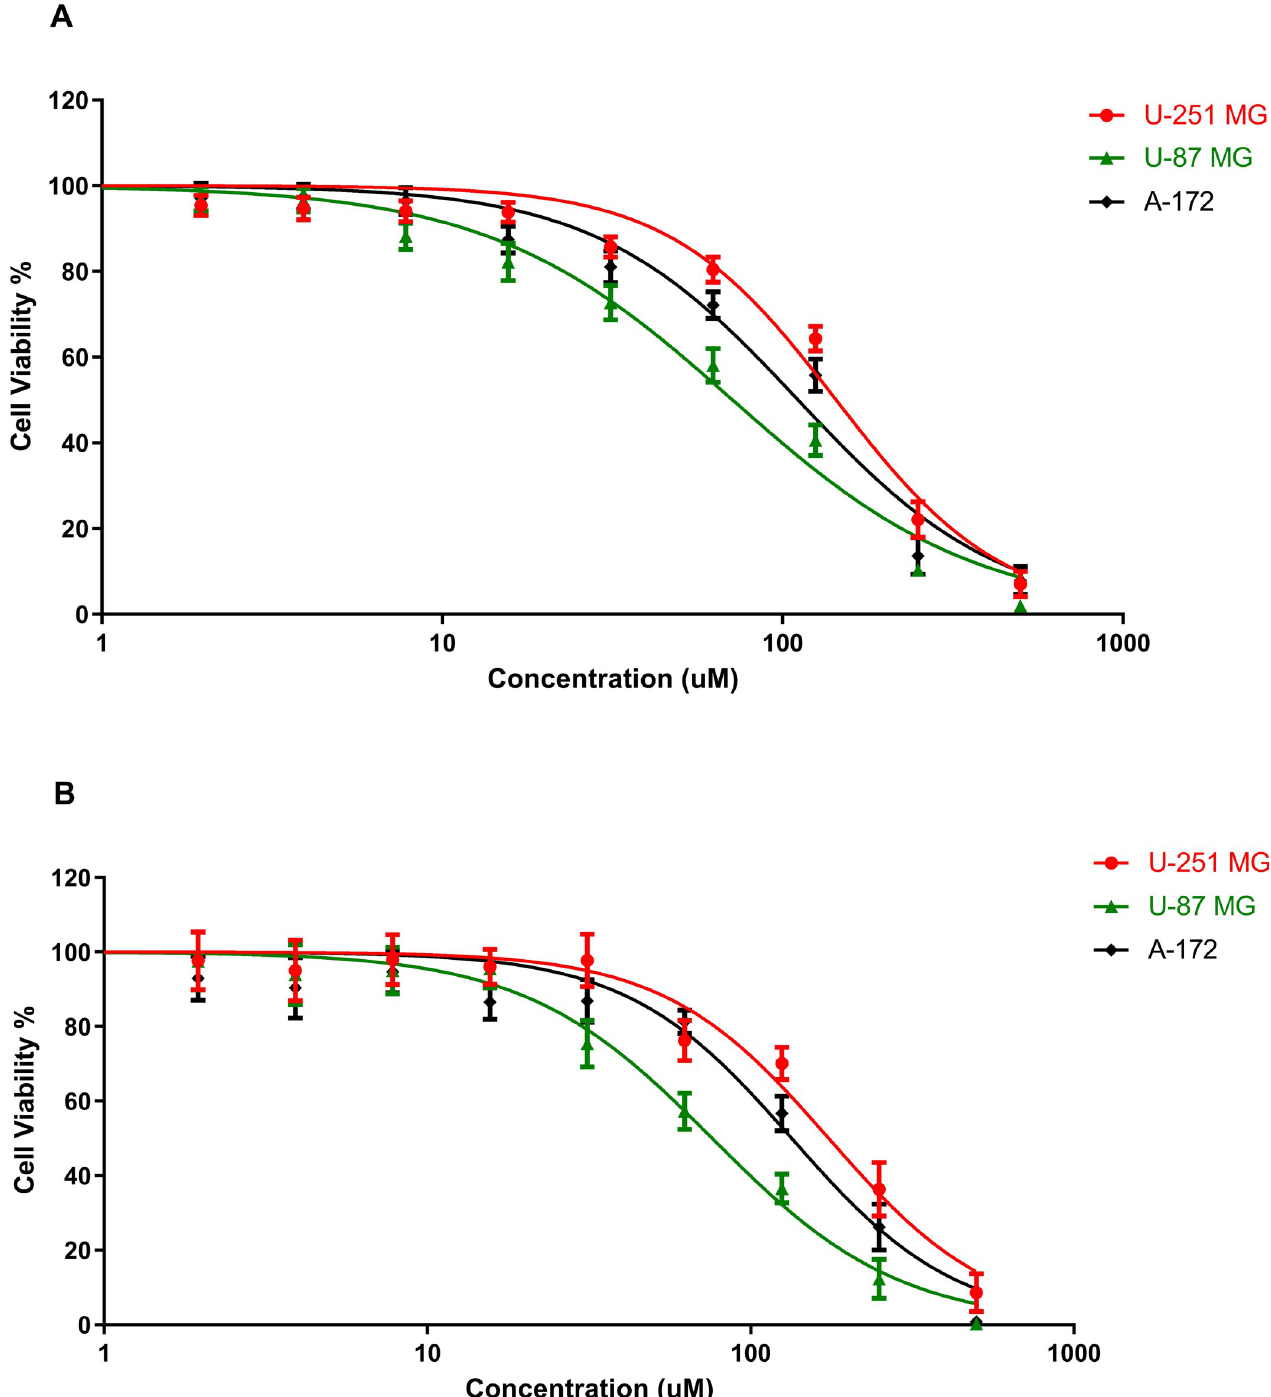
Fig 6. TMZ induced cytotoxicity in U-251 MG, U-87 MG and A-172 tumourspheres with 6 days post treatment incubation. A) Cytotoxicity analysis by using Alamar Blue ™ cell viability assay B) CellTiter-Glo 1 3D Cell viability assay.